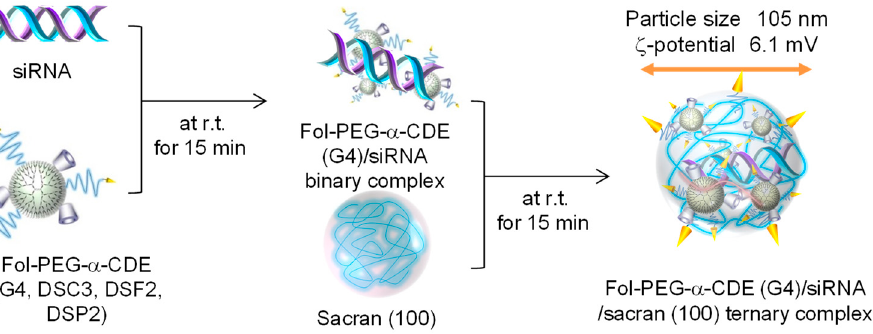
Figure 11. Preparation protocol and properties of Fol-PEG- α -CDE (G4, DSC2.9, DSF2, DEP2)/siRNA/sacran 100) ternary